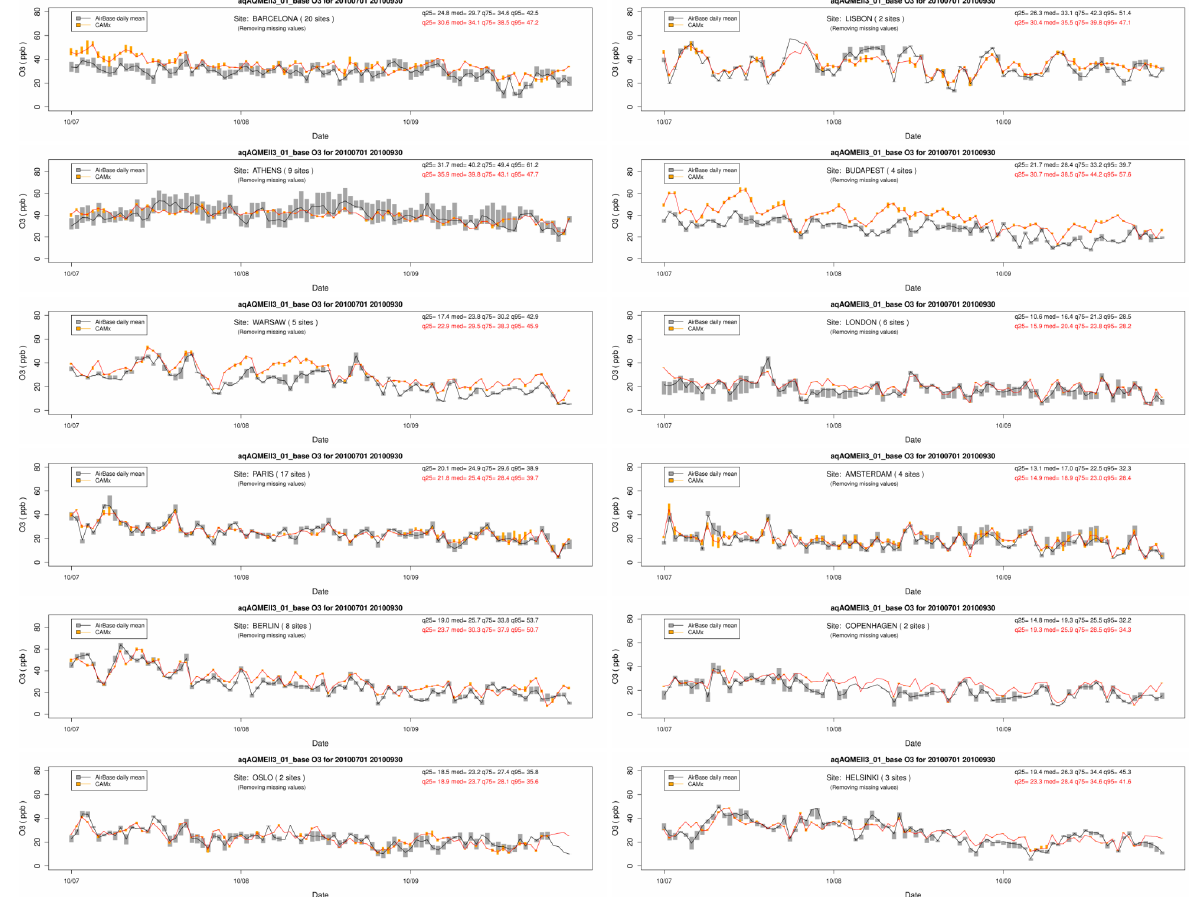
Figure 3. Time series of the box and whisker plots for the distribution of the observed (black and grey) and computed (red and orange) daily concentrations of O 3 at background AirBase sites in the selected cities for 1 July–30 September 2010. Bars show the interquartile range and lines show the median values. Values for the 25th, 50th, 75th, and 95th quantiles are also reported for each